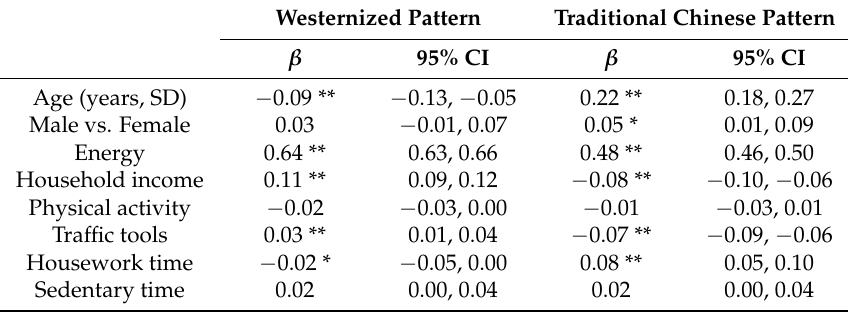
Table 3. Association of socio-demographics and lifestyle characteristics with dietary patterns in a nationally representative sample of Chinese children and adolescents ( β Coefficients and 95% confidence